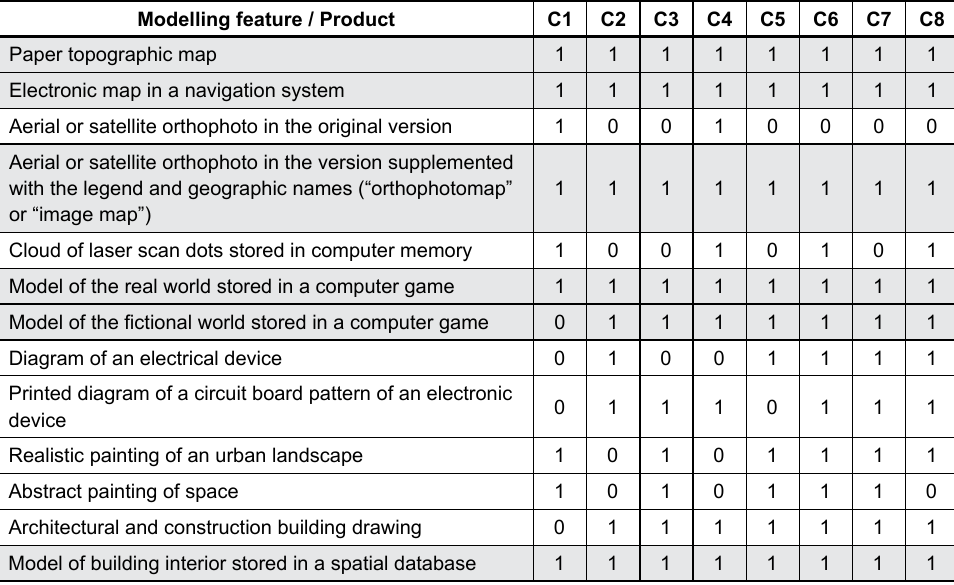
Tab. 1. Examples of spatial products used in this study along with information about the fulfillment of conditions associated with cartographic